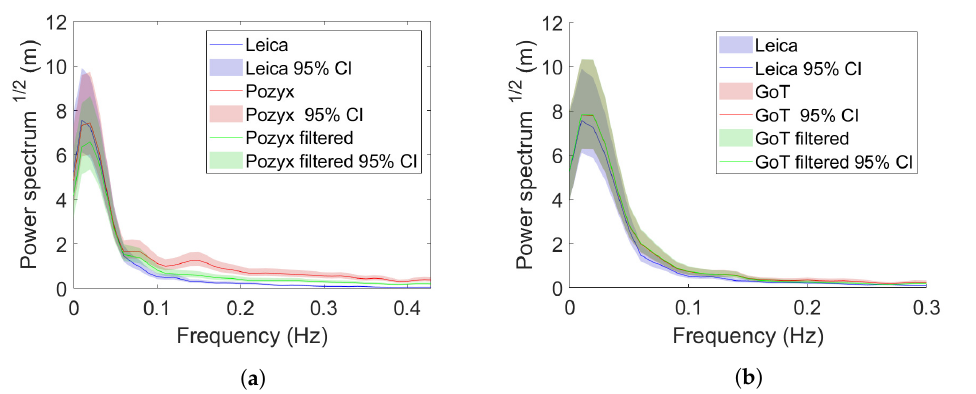
Figure 17. X-direction traces in the frequency domain after pre-filtering with and without Wiener filtering. ( a ) Leica/Pozyx. ( b ) Leica/GoT.